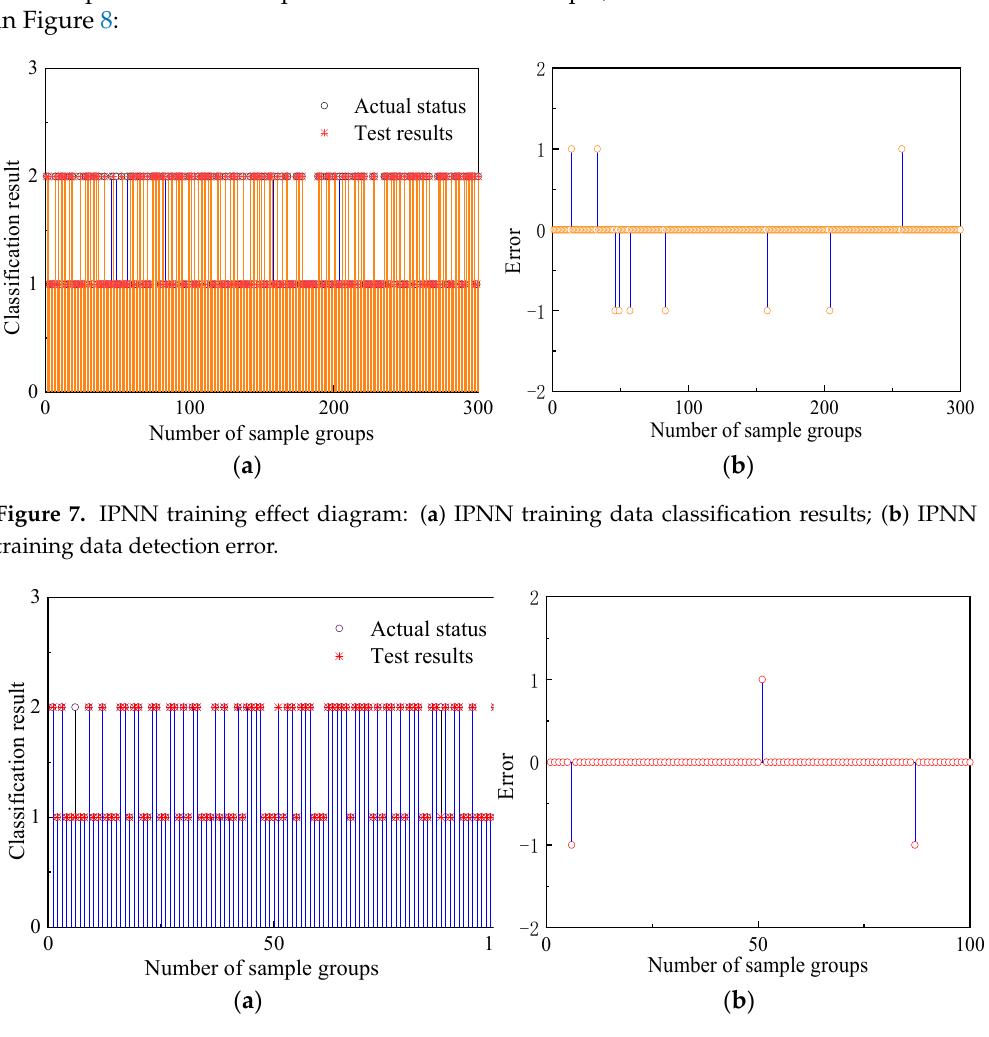
Table 2. The accuracy of signals under different models.